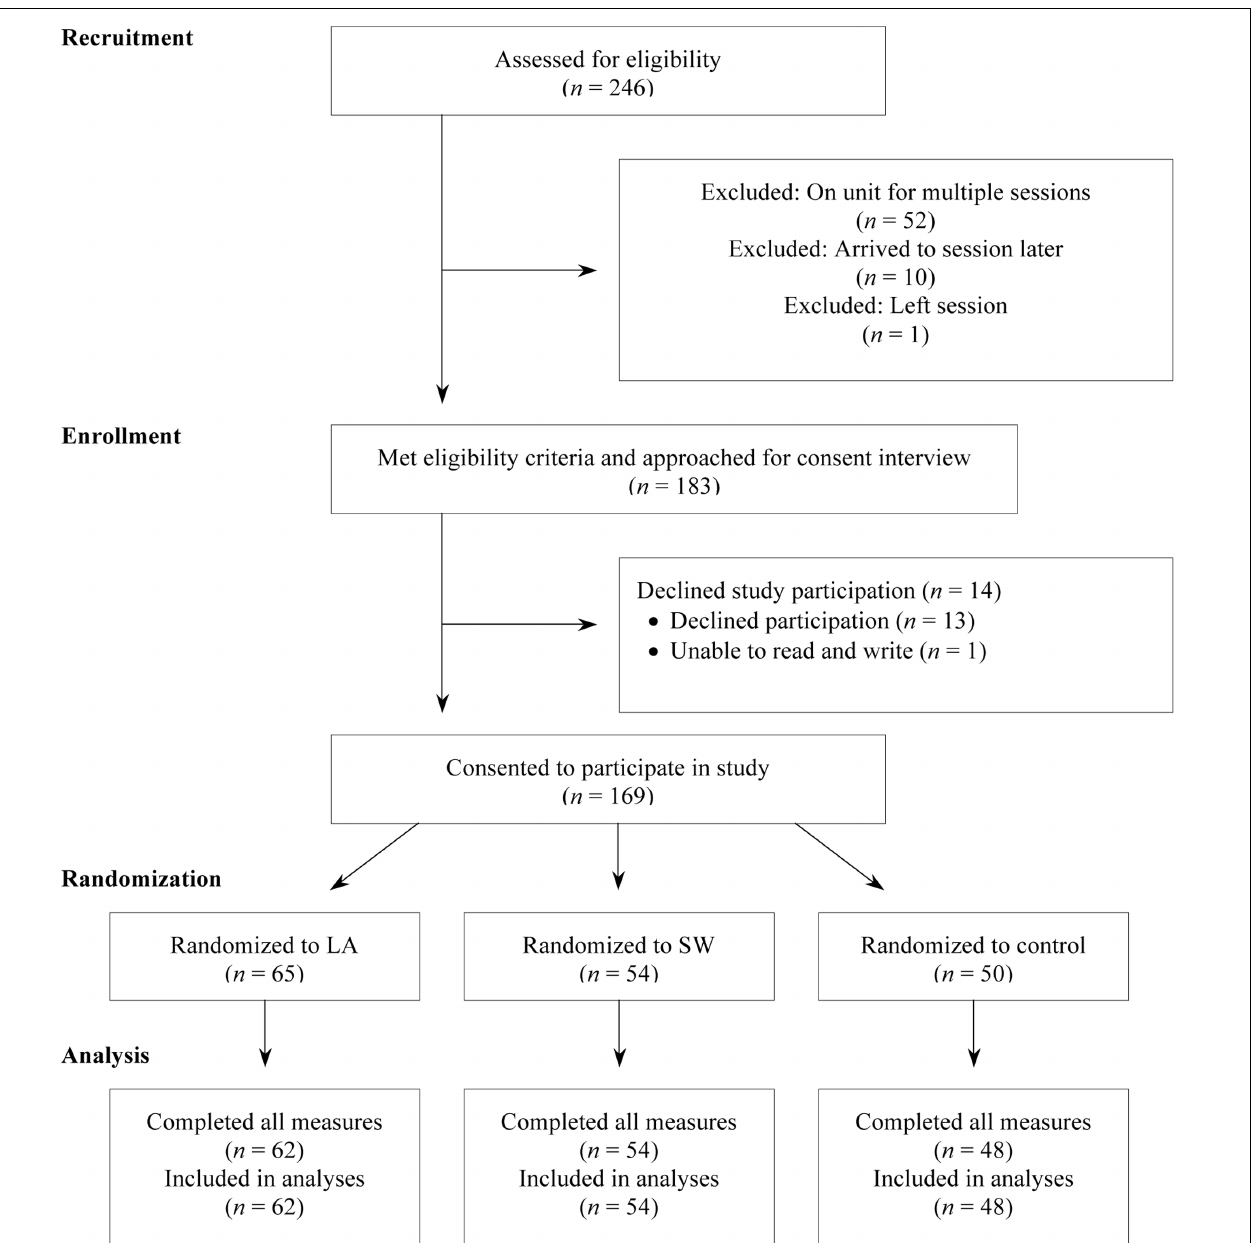
FIGURE 1 | Participant